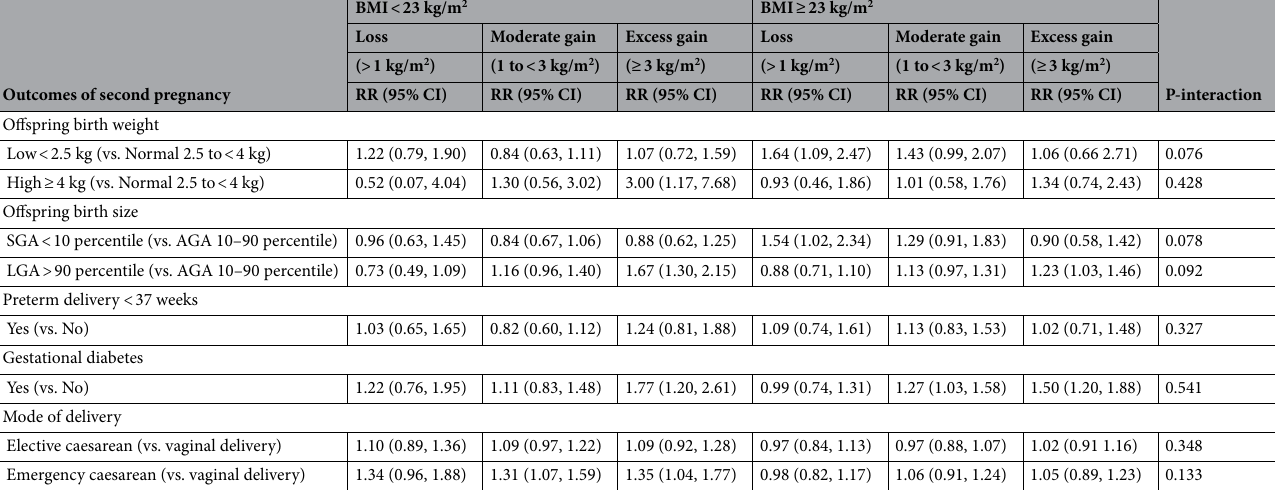
Table 3. Association between interpregnancy BMI change status and outcomes of second pregnancy, by weight status at 12-week gestation in the first pregnancy. Risk ratios are adjusted for maternal age and BMI at 12-week gestation in the first pregnancy, ethnicity, interpregnancy interval and respective pregnancy outcomes in the first pregnancy. BMI stable (− 1 to < 1 kg/m 2 ) serves as the reference group. BMI, body mass index; RR, risk ratio; CI, confidence interval; AGA, appropriate for gestational age; SGA, small-for-gestational-age; LGA,